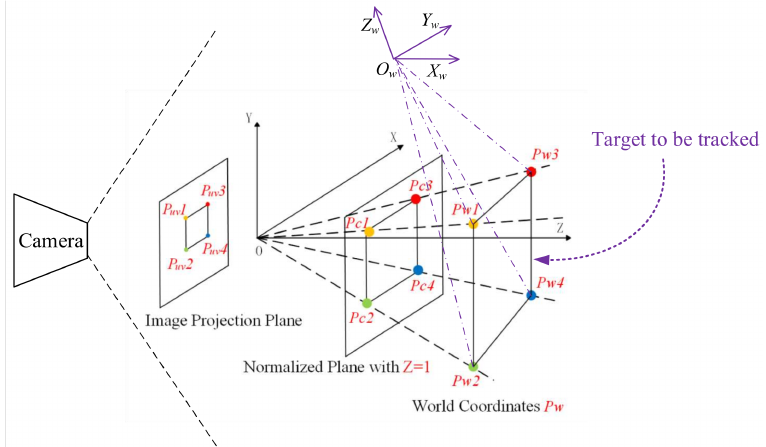
Figure 8. Schematic diagram of projection, transfer coordinate system and